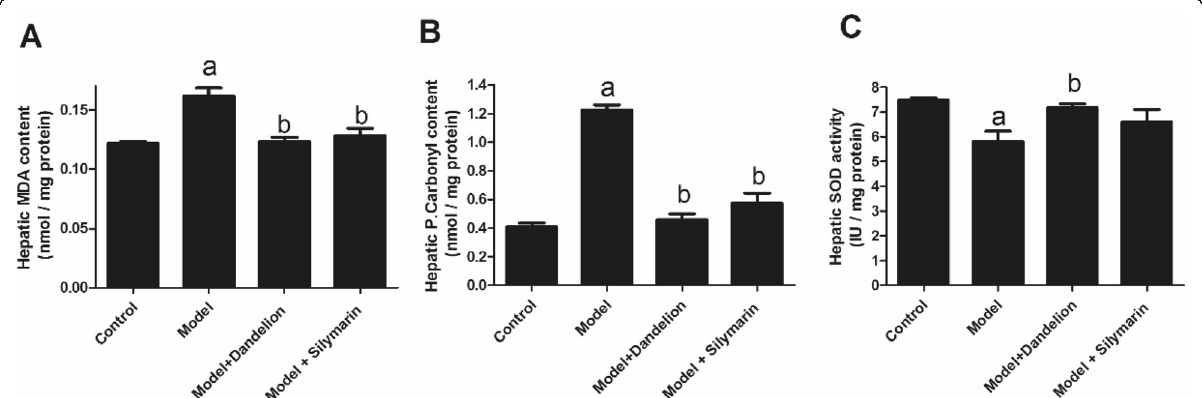
Fig. 4 Effect of dandelion and silymarin on hepatic markers of oxidative stress in CCL4 treated groups (model). Data are presented as mean ± SEM for 6 animals per group. MDA and P. carbonyl units are nmol/mg protein; SOD enzyme unit is IU/mg protein. a P < 0.05 vs. control group. b P < 0.05 vs. model